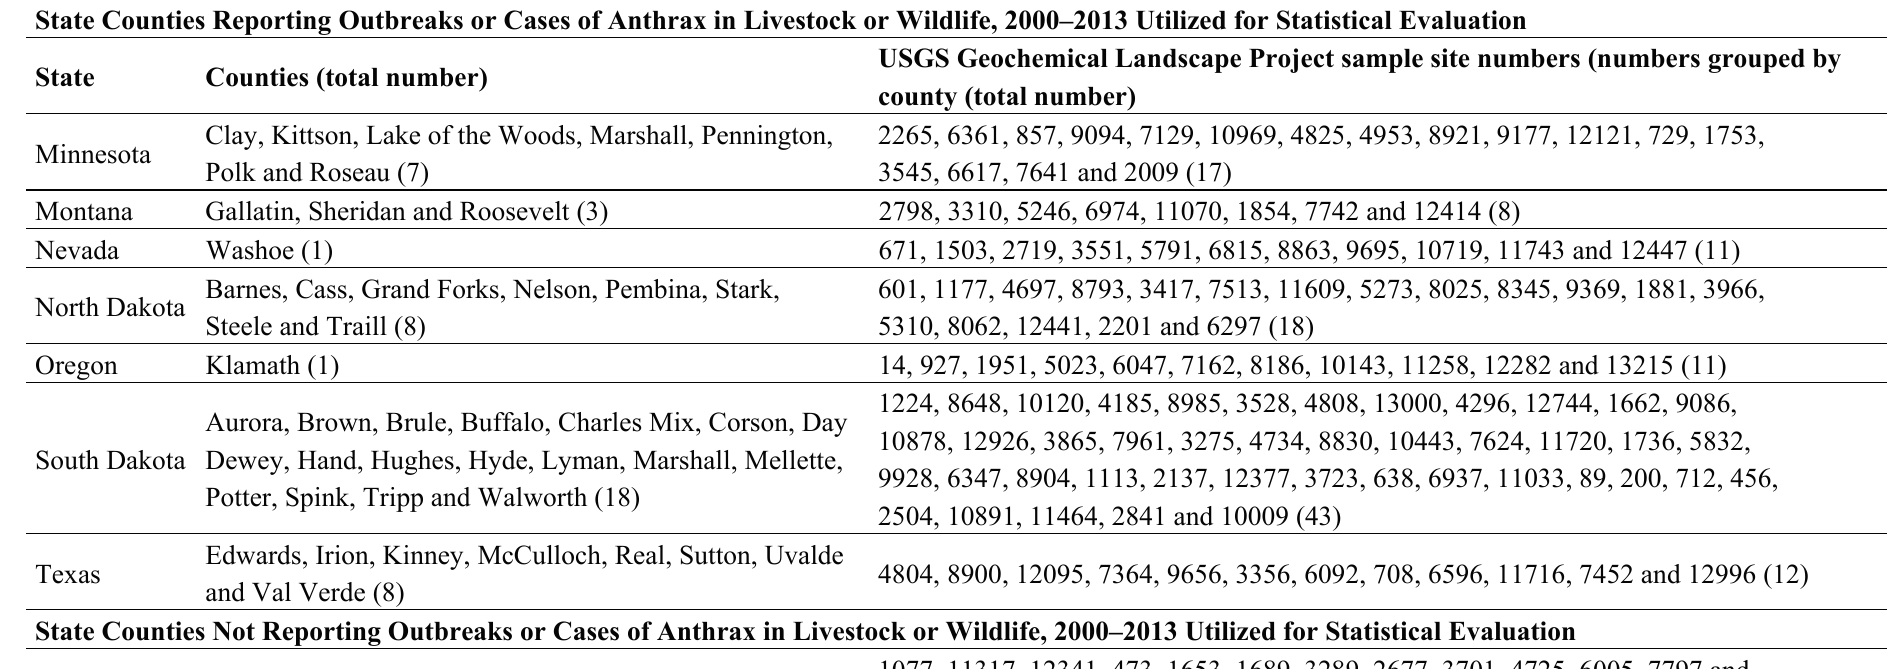
Table 1. State, county and U.S. Geological Survey’s (USGS) sample site data